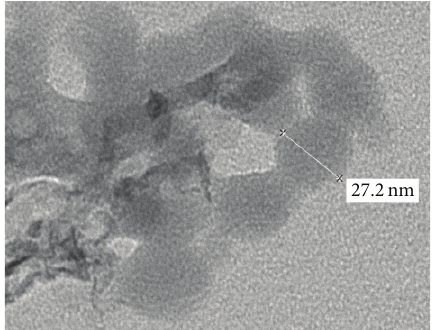
Figure 1: TEM of glucan-Fe 3 O 4